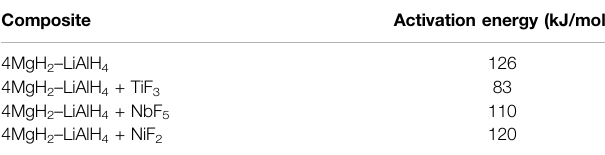
TABLE 4 | Apparent activation energy for the MgH 2 -LiAlH 4 composite with different selected metal halides (Ismail et al., 2011). Composite Activation energy